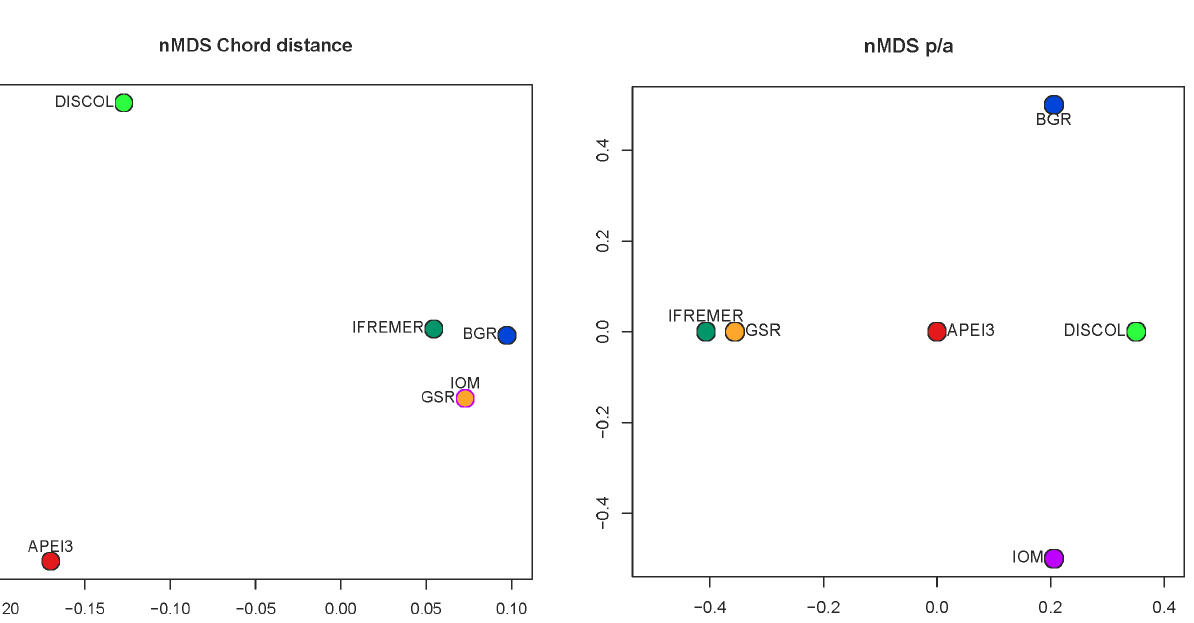
Figure 10. The nMDS ordination plot of Euclidean distance be- tween areas of presence–absence transformed